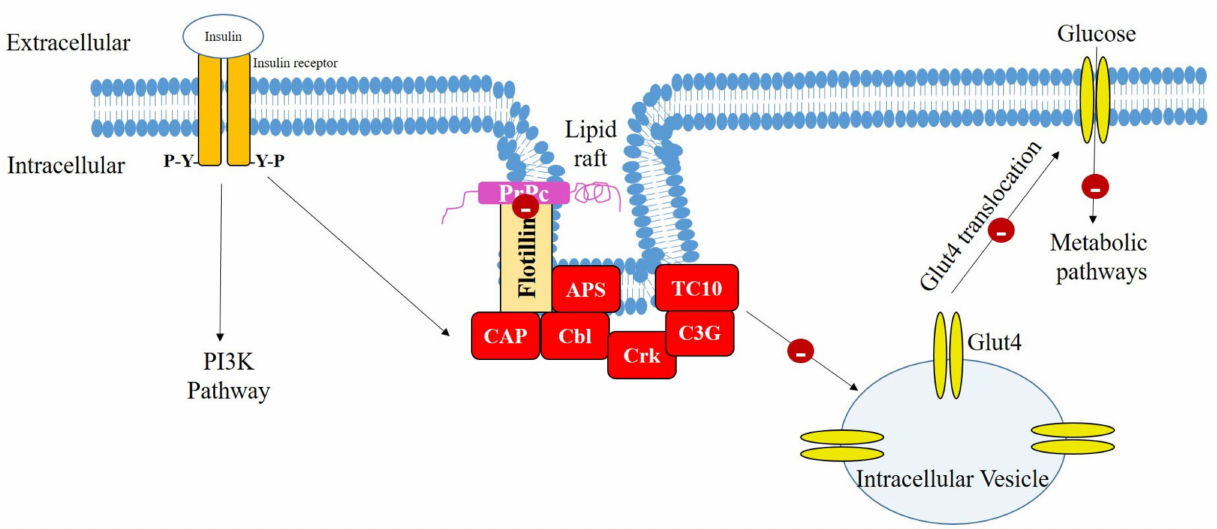
Figure 7. Possible mechanism of action of insulin resistance following traumatic brain injury (TBI) in mice brains. Dis- lodgement of PrPc results in the disruption of PrPc and flotillin interaction that may lead to the loss of CAP/Cbl/TC10 signaling cascade. This results in the inhibition of Glut4 translocation to the cell membrane and thus insulin resistance occurs. PrPc: lipid raft-localized cellular prion protein; CAP: Cbl-associated protein; APS: adaptor protein containing PH and SH2 domains; Glut4: glucose transporter 4; PI3K: